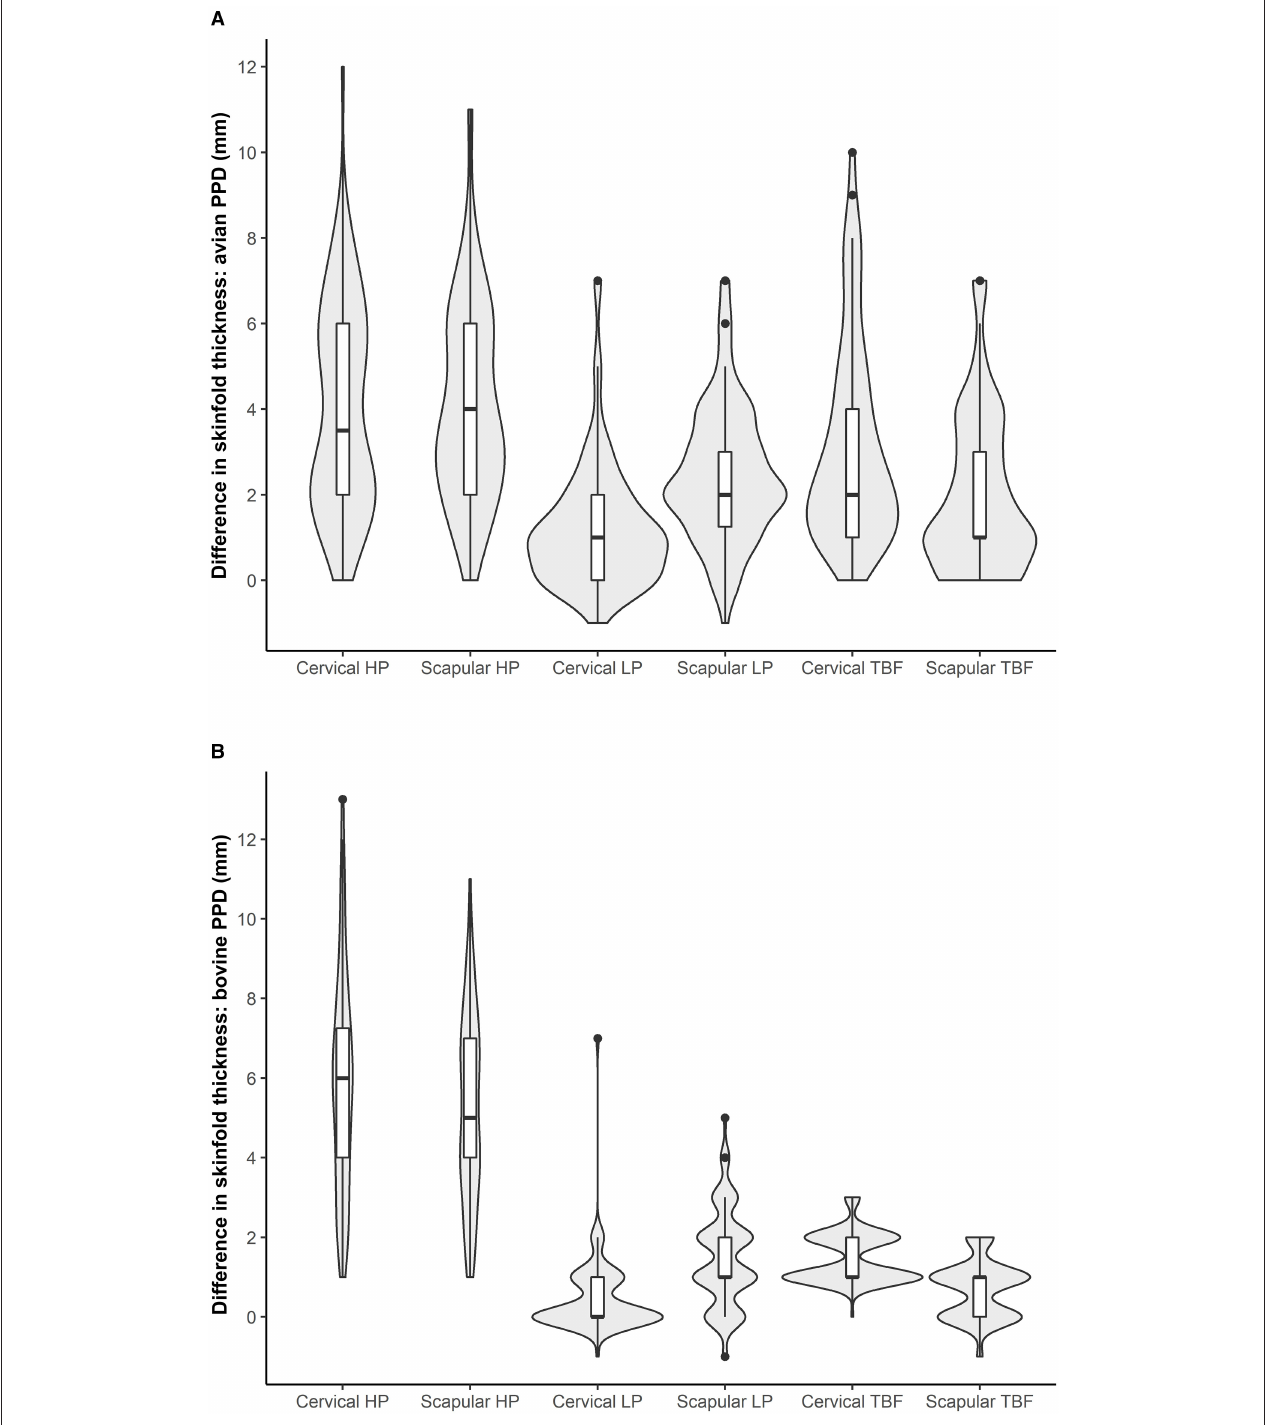
FIGURE 2 | Distribution of difference in skinfold thickness after avian (A) and bovine (B) PDD injection on cervical and scapular sites in high prevalence (HP), low prevalence (LP), and TB-free (TBF) herds. The frequency of skinfold thickness measures observed in each group is correlated with the curves of the violin plot.